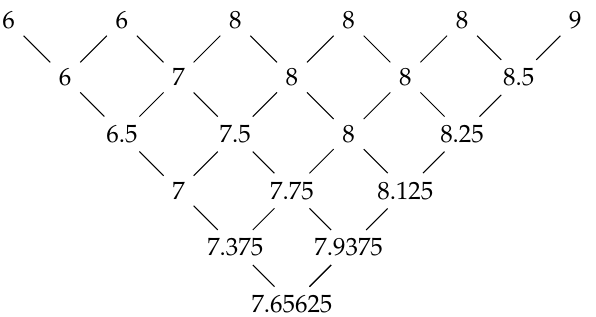
Figure 3. Recursive method to compute the F -rule by just using means of pairs of